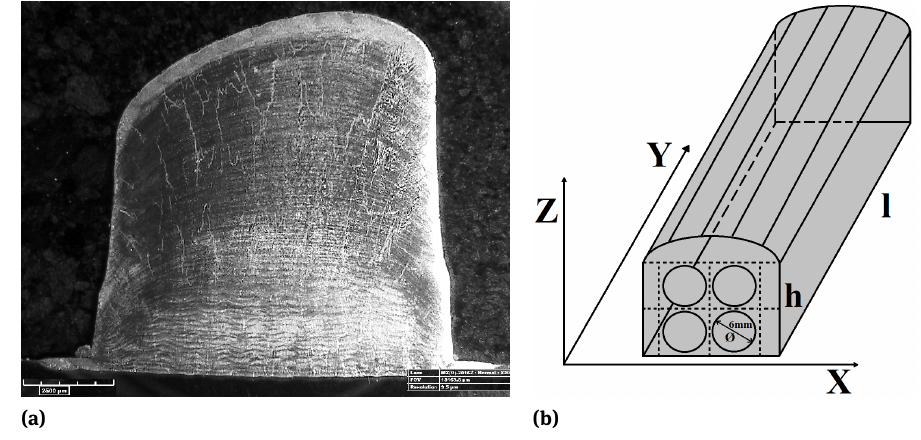
Figure 2: Manufactured multilayer cuboid sample in cross section